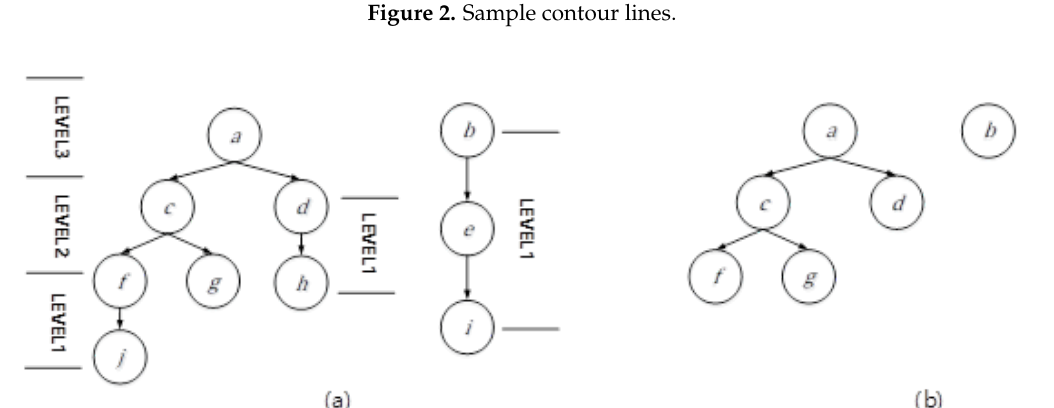
Figure 2. Sample contour lines.